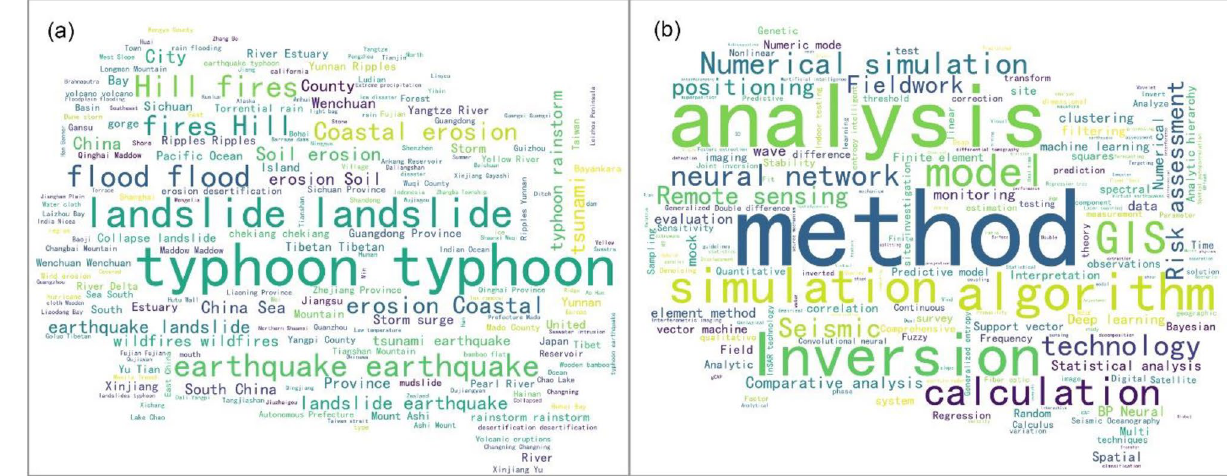
Figure 8. Word cloud of the identification results of the recognition geological structure literature: ( a ) natural hazards and geographical location, ( b ) research method. The larger the font in the word cloud is, the higher the frequency of occurrence. The larger the font in the word cloud is, the higher the frequency of